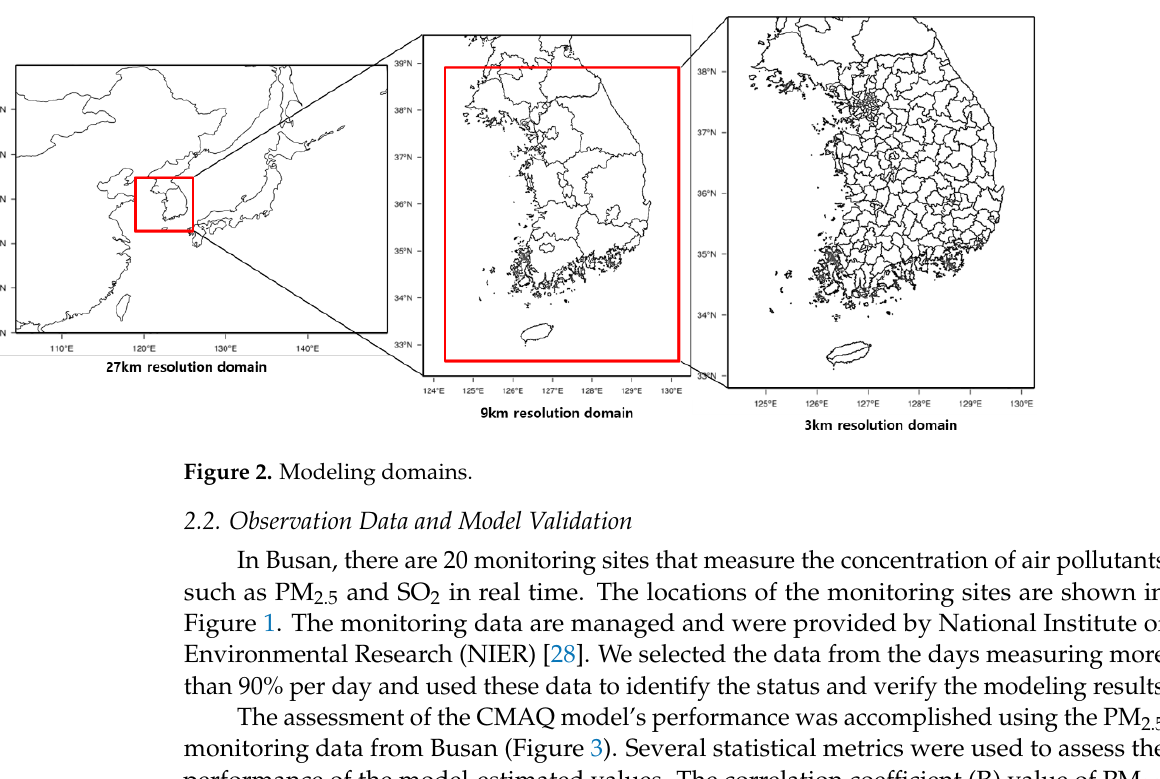
4 of 16 Table 2. Summary of CMAQ configuration. Category